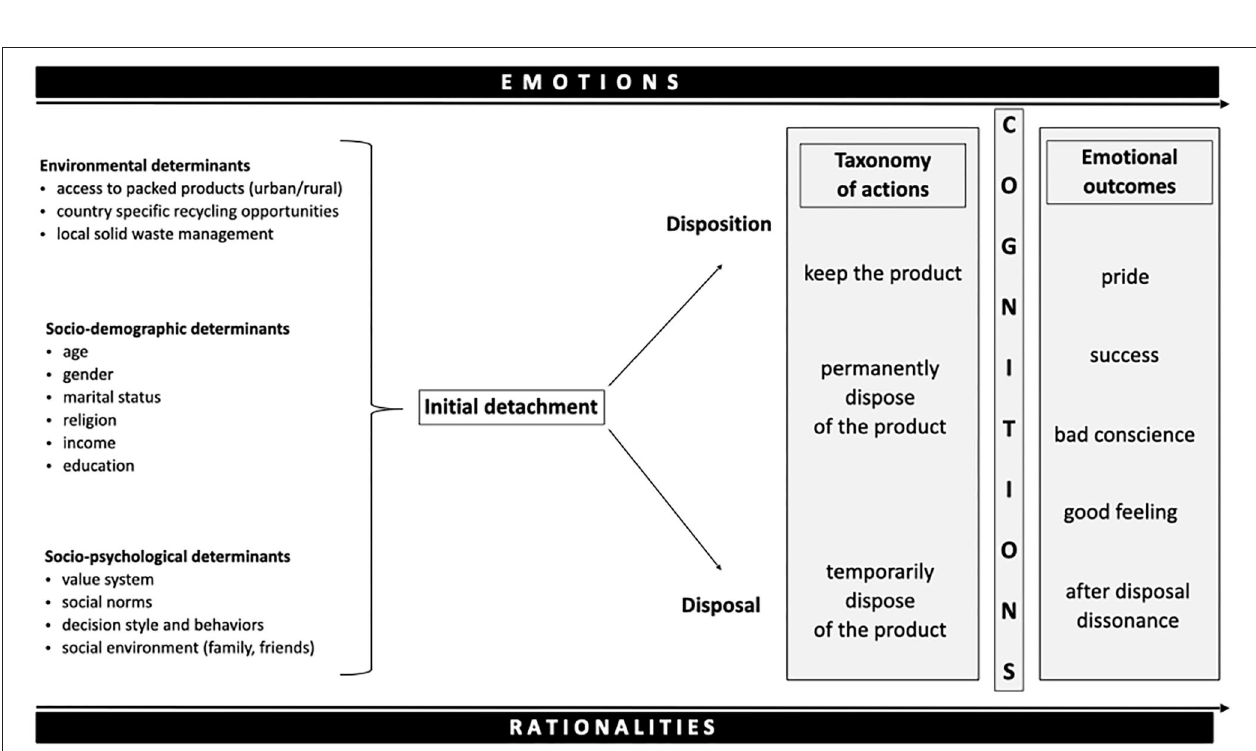
FIGURE 3 | Overview of respondent’s disposal decisions according to their seven household possessions.